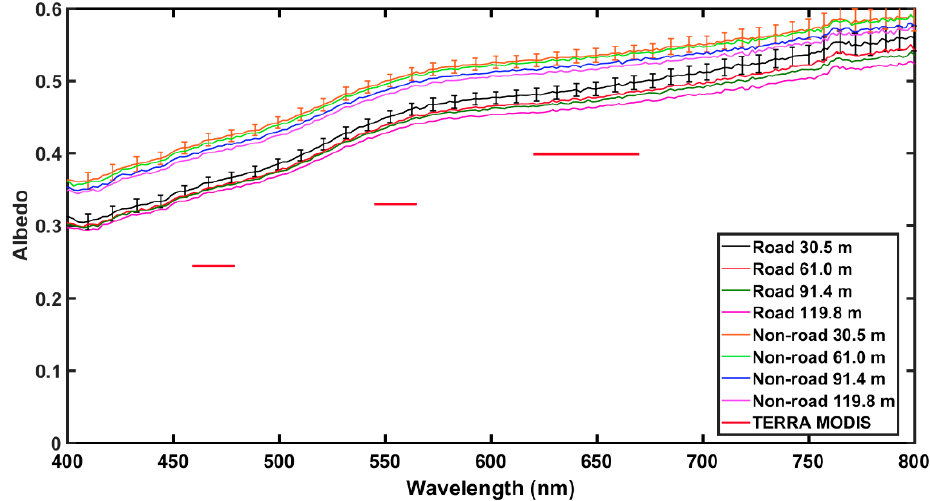
Figure 11. Same caption as Figure 10 but for Terra MODIS.